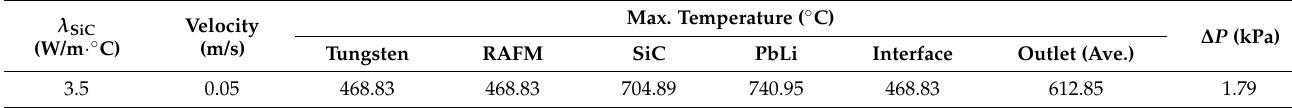
Table 4. Results of typical thermal hydraulic analysis